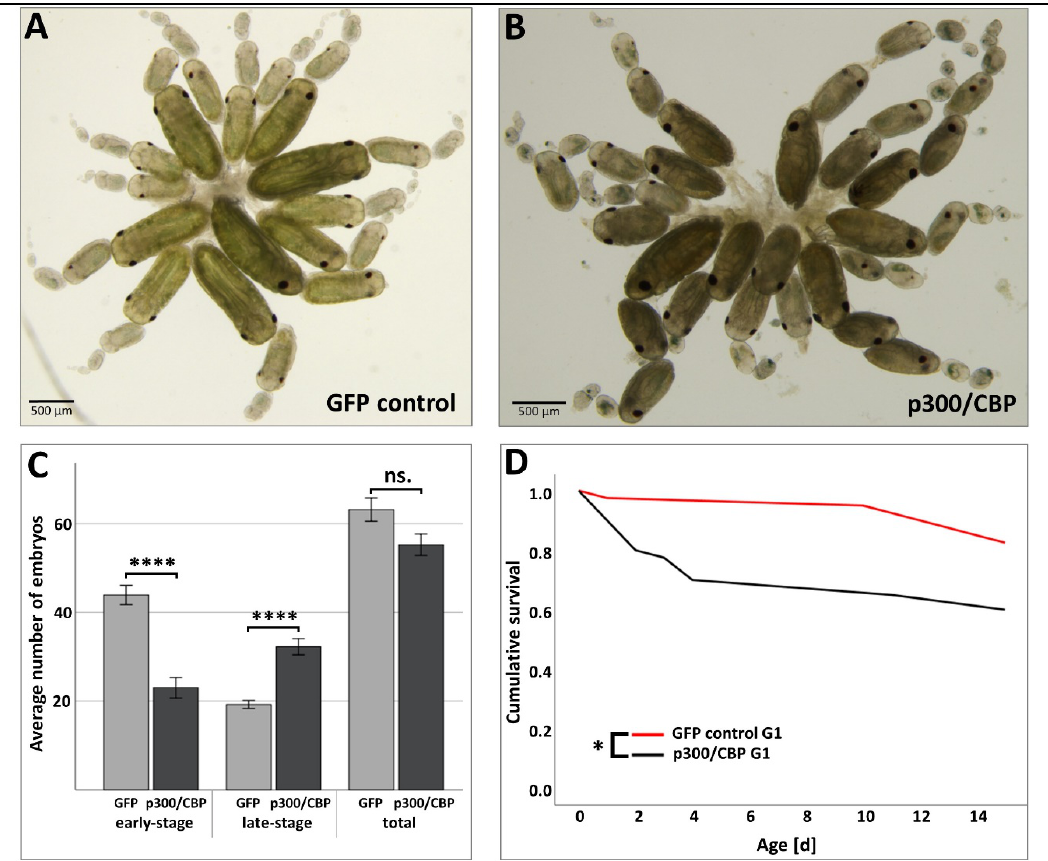
Figure 6. Effect of RNAi-mediated p300/CBP mitigation on the development and survival of the G1 generation of A. pisum mothers injected with dsRNA. Ovaries were dissected from aphids 10 days post-injection with ( A ) GFP control dsRNA or ( B ) p300/CBP dsRNA. ( C ) The distribution of early stage embryos (up to stage 17, no visible eyes) and late-stage embryos (stage 18 and beyond, visible eyes) differed significantly between the treatments. Ovaries from aphids treated with p300/CBP dsRNA contained significantly fewer early stage embryos ( p < 0.0001) and significantly more late-stage embryos ( p < 0.0001) than the GFP control group, but there was no difference in the total number of embryos. ( D ) The survival of G1 aphids from the p300/CBP dsRNA treatment group was compared to the GFP control group for 2 weeks. The survival of aphids in the p300/CBP dsRNA treatment group was significantly reduced compared to the control group ( p < 0.05). The number of embryos was analyzed using Student’s t -test. Survival data were evaluated using Kaplan–Meier statistics and comparisons between the treatment and control were based on log-rank tests. Statistical significance is indicated as follows: * p < 0.05, **** p < 0.0001, ns—not significant.